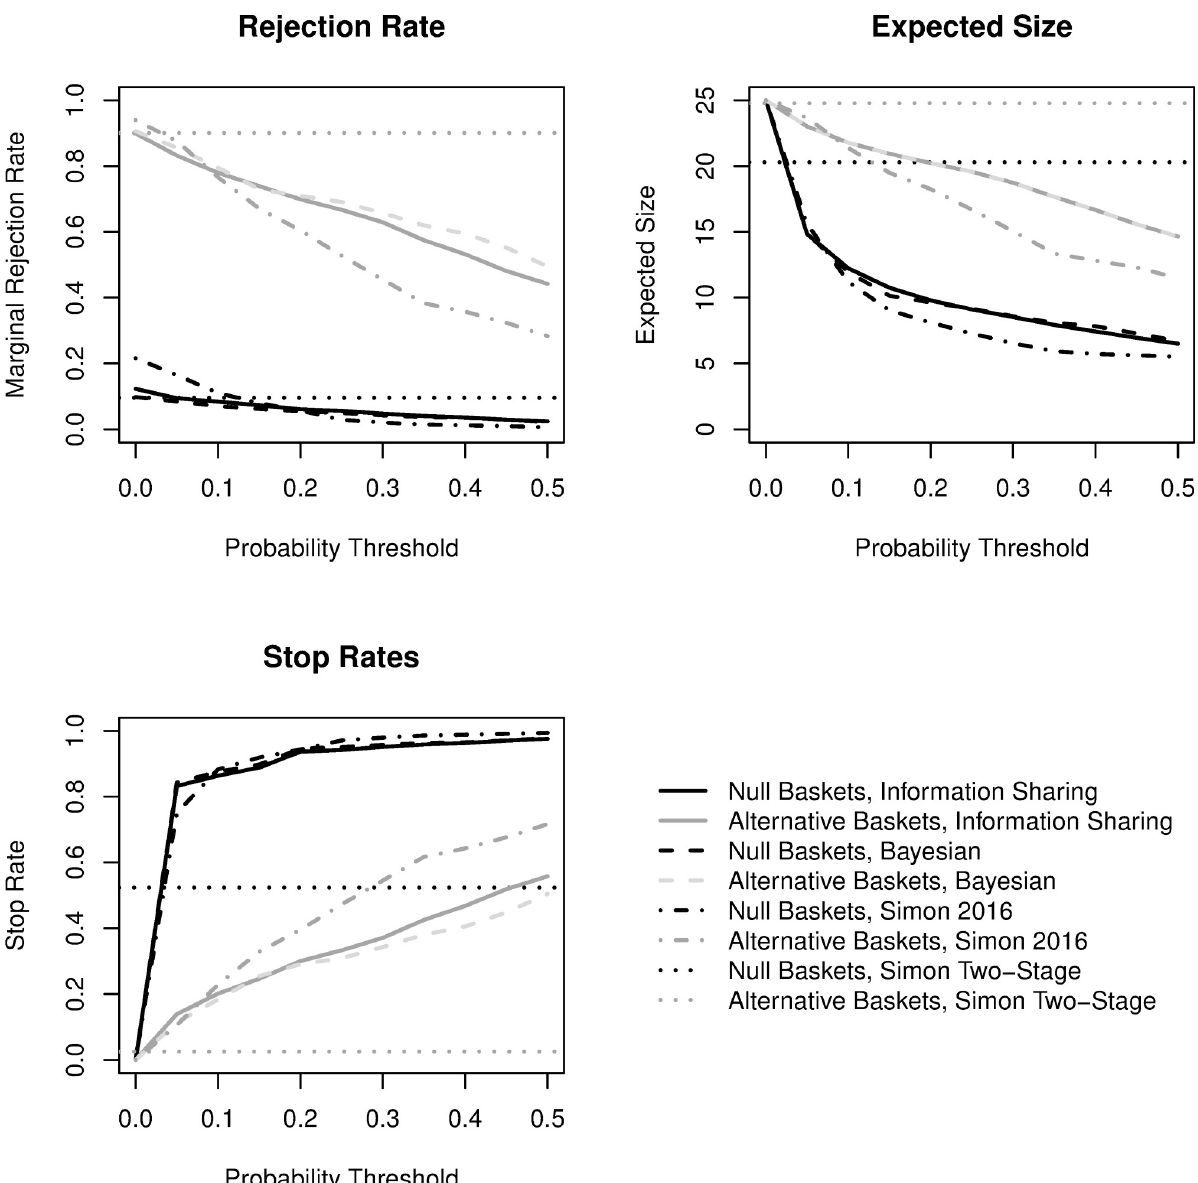
Fig 3. Comparisons of trial operating characteristics for mixed scenario (8 null, 2 alternative baskets). Black coloring is for null baskets and gray coloring for alternative baskets. The dotted lines represent Simon’s two-stage minimax design, dashed lines represent a design with interim monitoring after each participant based on Bayesian predictive probability futility monitoring, dashed-dotted lines represent Simon’s (2016) design with information sharing with posterior probability futility monitoring, and the solid lines represent a Bayesian design that also facilitates information sharing across baskets based on exchangeability of the response rate with predictive probability futility monitoring. The rejection rate summarizes the proportion of baskets across the 1000 simulated trials where efficacy was concluded, the expected sample size presents the average number enrolled in a given null or alternative basket, and the stop rate describes the proportion of baskets that terminated early at any point for